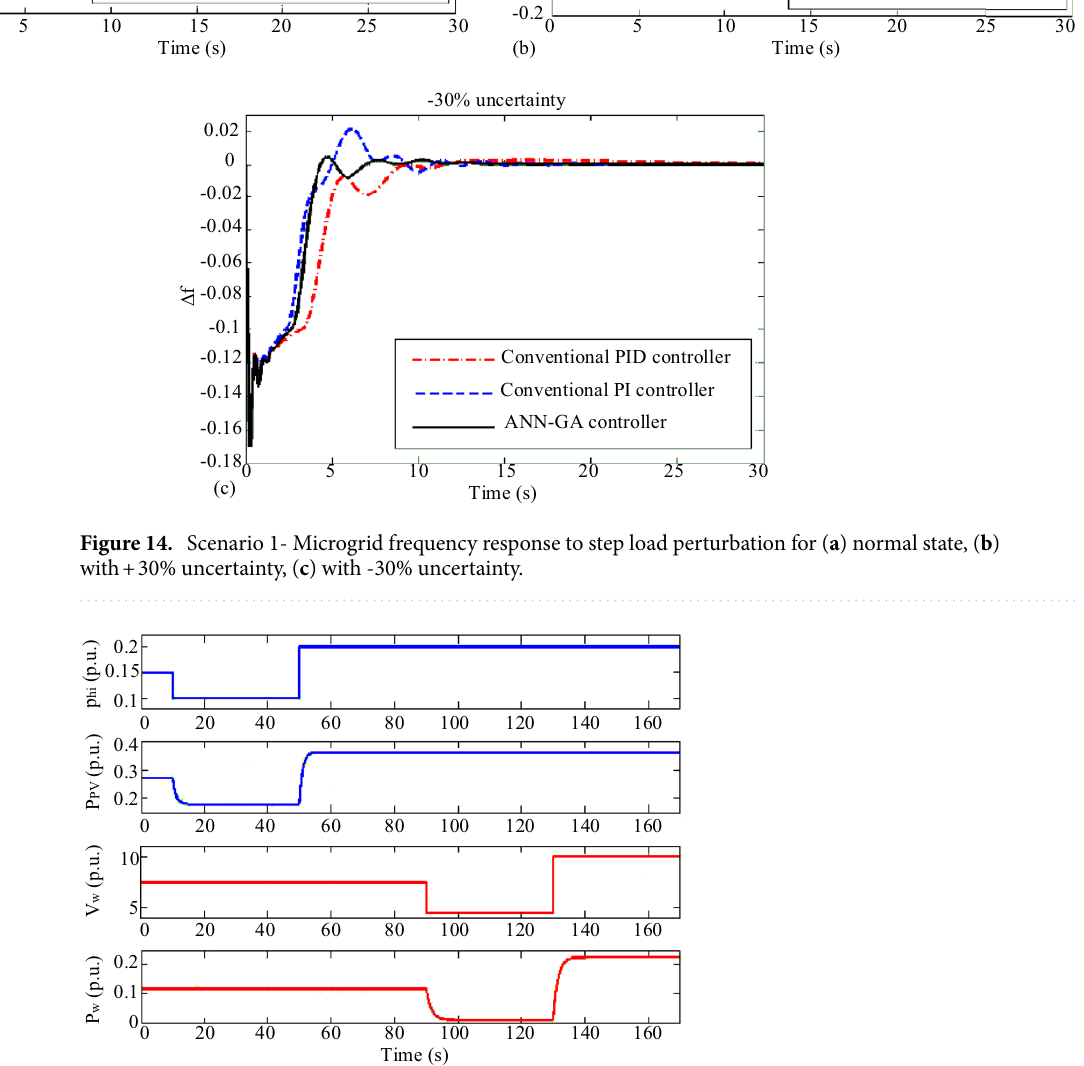
Figure 15. Scenario 2- Disturbances applied to wind speed and solar irradiation and related output